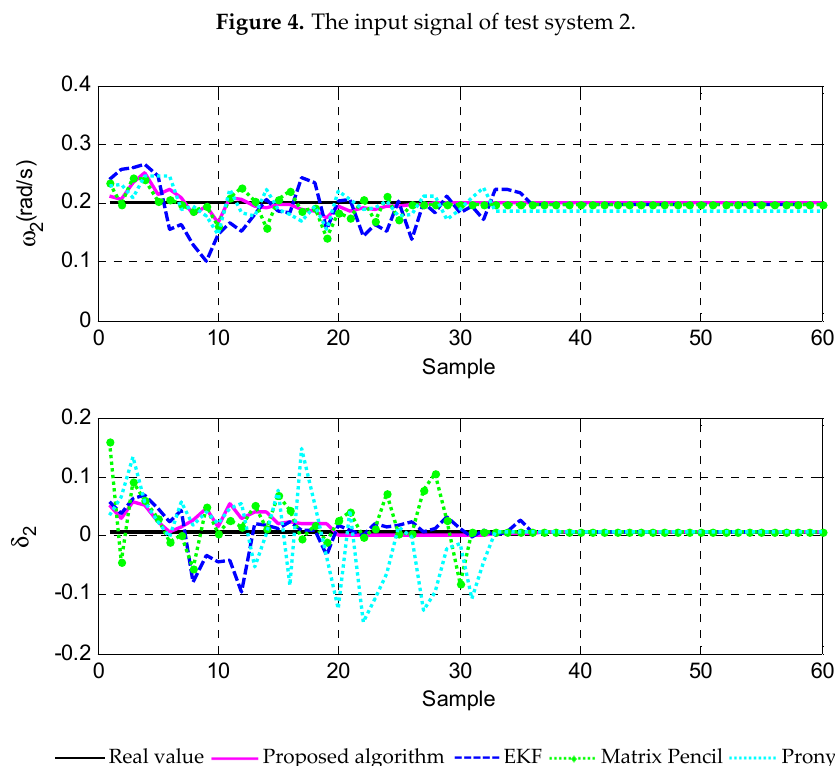
Matrix Pencil Prony ω δ , by using different methods. 2 2